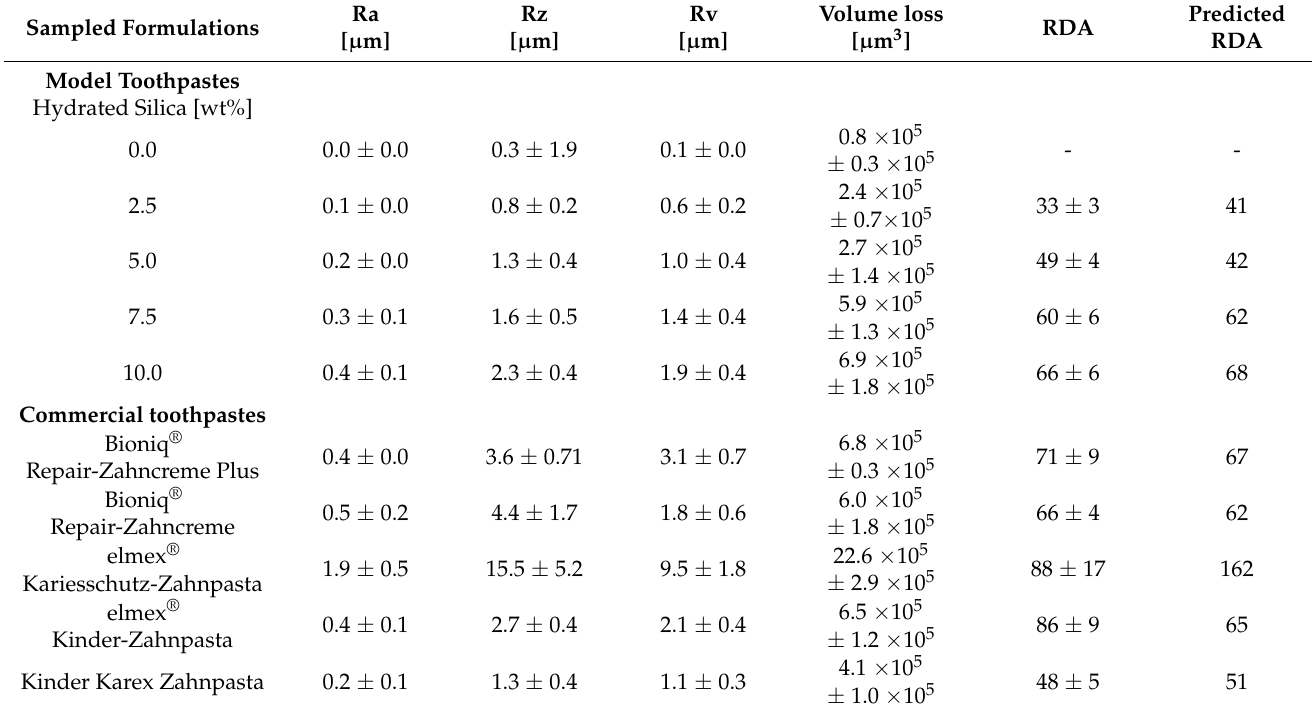
Table 4. Roughness parameters Ra, Rz and Rv and volume loss values obtained by profilometric analysis of our abrasion tests with all toothpaste samples, together with the obtained RDA values. The predicted RDA values are based on the volume loss calibration curve calculated from the model toothpaste abrasivity